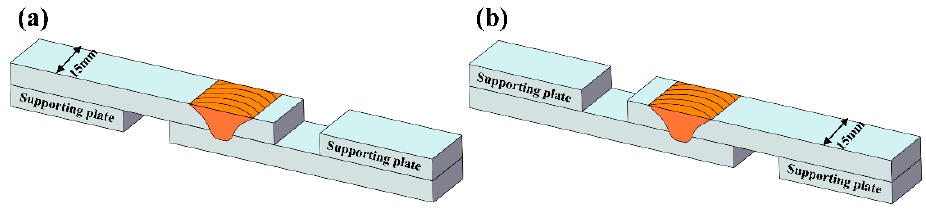
Figure 4. Schematic of tensile shear specimens: ( a ) configuration A and ( b ) configuration B.